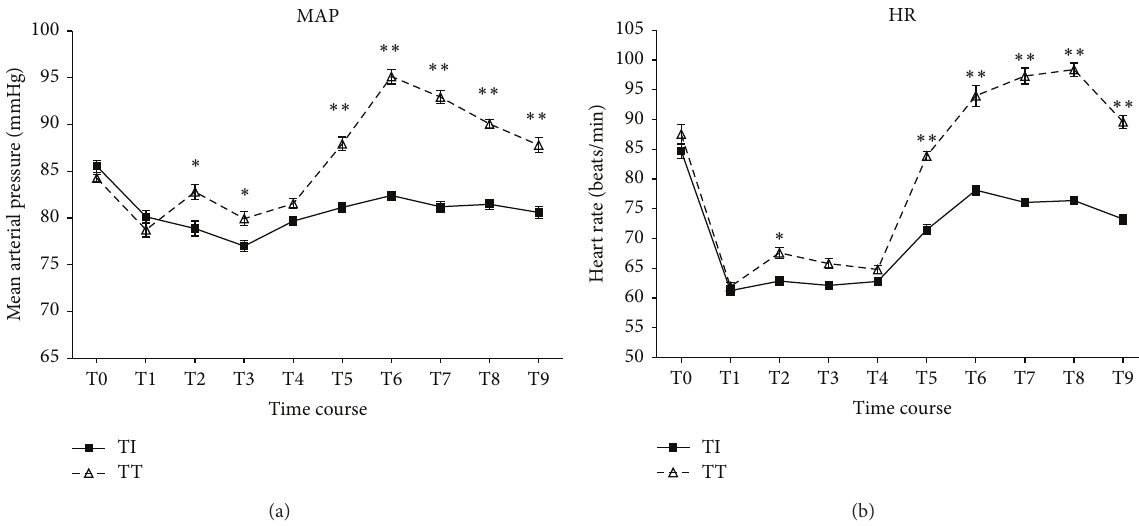
Figure 2: Changes in mean hemodynamic variables in patients with a tracheal tube intubation (Group TT) or an I-gel facilitated endotracheal tube intubation (Group TI) during the study; bars indicate the SEM. Both groups had significant reduction in MAP and HR from their respective baseline values till the end of the surgery. Patients in Group TI had a greater fall in comparison to Group TT over the time period of the observation ( 𝑃 < 0.0001 ). During emergence from anesthesia, MAP and HR in Group TT were significantly higher than that at baseline ( 𝑃 < 0.0001 ). And the intergroup differences were also significant ( ∗ 𝑃 < 0.05 ; ∗∗ 𝑃 < 0.0001 ). Baseline (T0); before anesthetic induction (T1); endotracheal tube intubation (T2); 3 min after intubation (T3); end of surgery but before awakening (Group TT) or before endotracheal tube